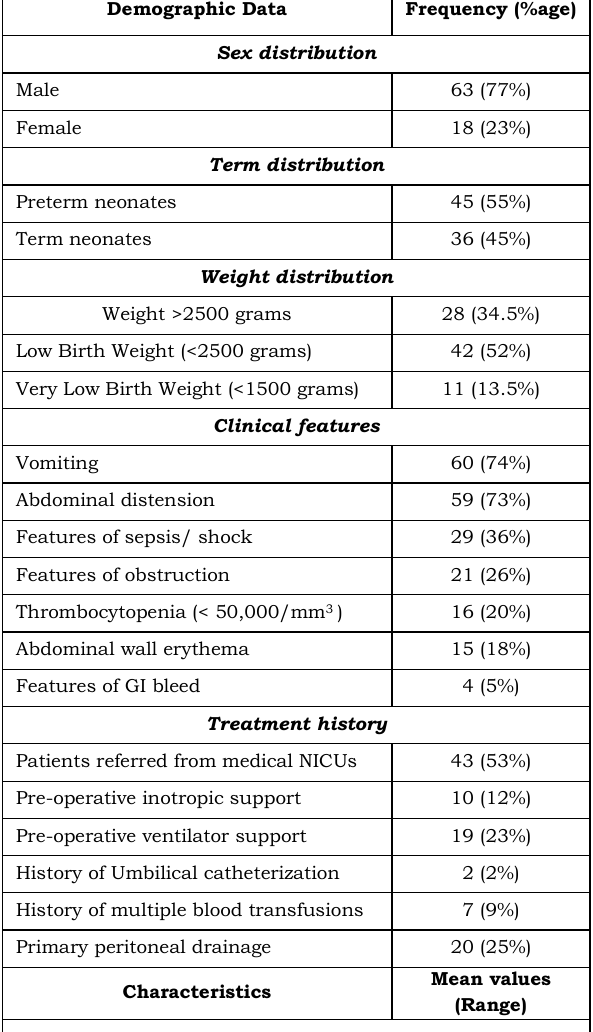
Table 2: Demographic characteristics and clinical findings in our patients Demographic